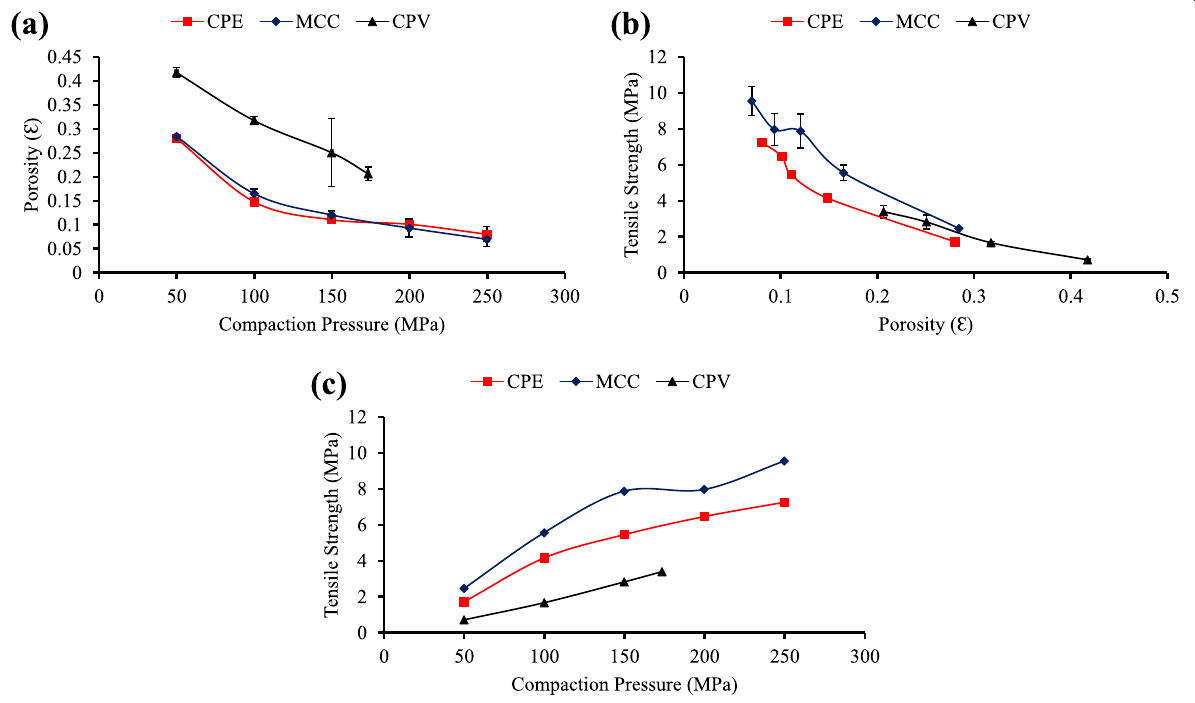
Fig. 2 a Compressibility plot. b Compactibility plot. c Tabletability